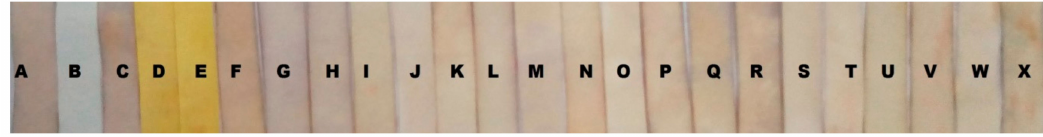
Figure 17. Color change on paper strips coated with the receptor 1, dipped in the solutions of acetate salts of various metal ions. [ 1 ] = 20 µ M. From left to right, A = Free, B = Hg 2 + , C = Al 3 + , D = Cr 3 + , E = Fe 3 + , F = Cu 2 + , G = Rb + , H = Sm 3 + , I = Zn 2 + , J = K + , K = Gd 3 + , L = Pb 2 + , M = Ca 2 + , N = Ni 2 + , O = Cd 2 + , P = Fe 2 + , Q = Mg 2 + , R = Pd 2 + , S = Na + , T = Cs + , U = Li + , V = Ba 2 + , W = Co 2 + , X = Sr 2 + .